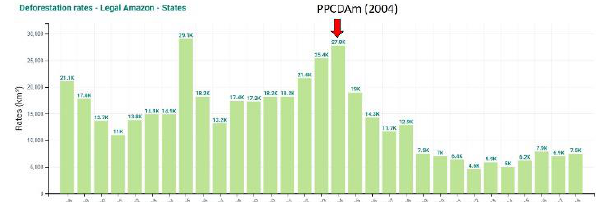
Figure 3. Deforestation rates (km²/year) in the Legal Amazon between 1988 and 2018 and the visible success in curbing forest loss after PPCDAm creation. Source: Edited from Terrabrasilis (http://terrabrasilis.dpi.inpe.br).